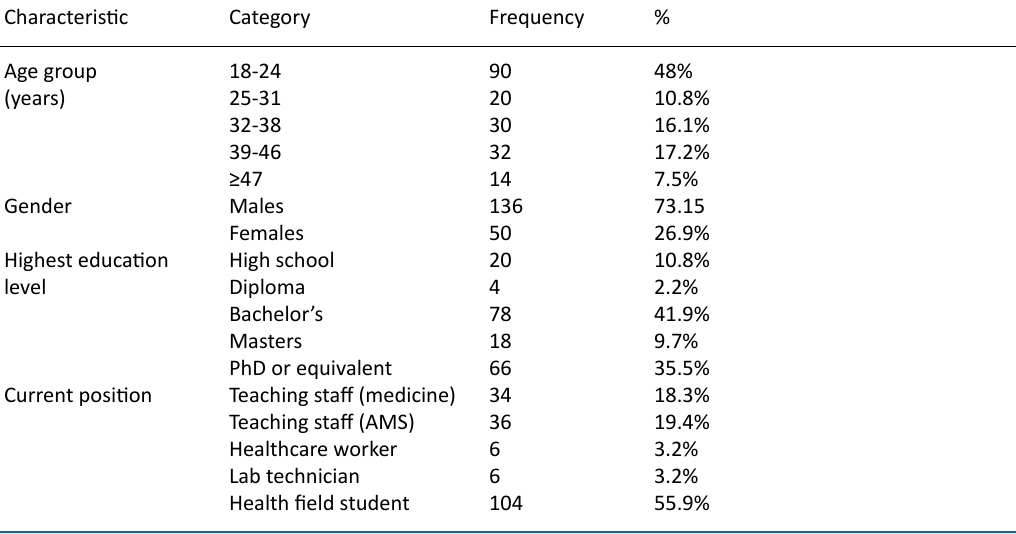
Table 1. Sociodemographic characteristics of participants (n=186)